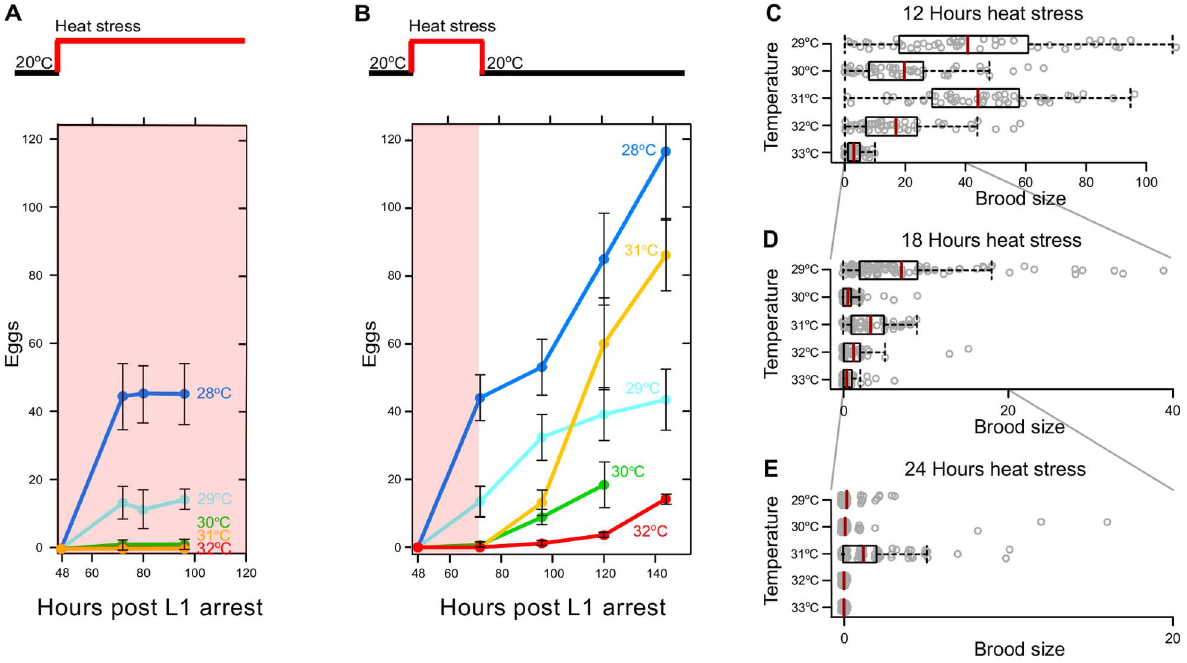
Figure 1. Hermaphrodites can recover egg laying after 24 hours of heat stress. (A) Average numbers of eggs laid by individual hermaphrodites when shifted (from 20 u C) to stress temperatures between 28 u C and 32 u C. Note that at 20 u C worms lay , 300 eggs. (B) Average numbers of eggs laid by individual hermaphrodites that were shifted back down to 20 u C after 24 hours of heat stress. Error bars represent s.d. Brood sizes produced by individual hermaphrodites stressed for (C) 12, (D) 18, and (E) 24 hours. Each gray circle represents one animal. Vertical red lines on box plots represent means.